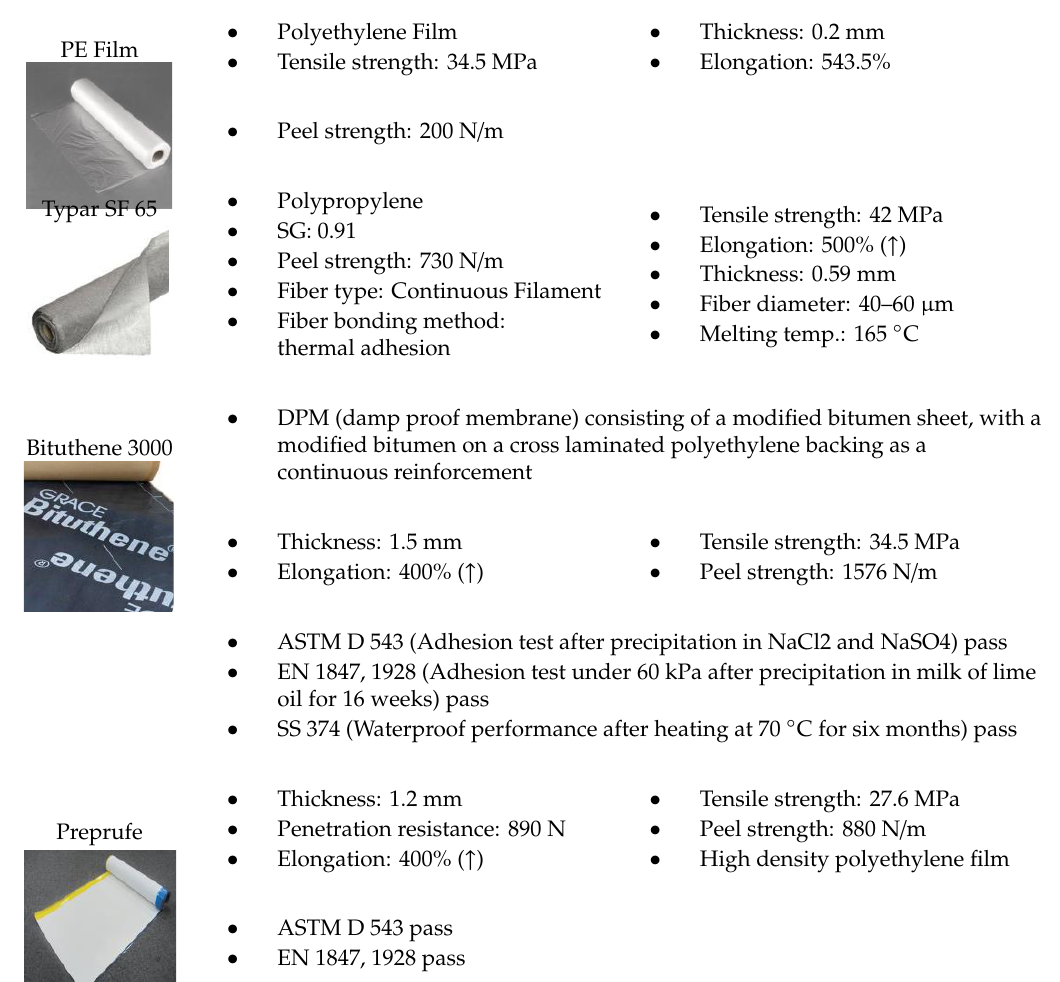
Table 3. Composition of test specimens from protective waterproof materials.